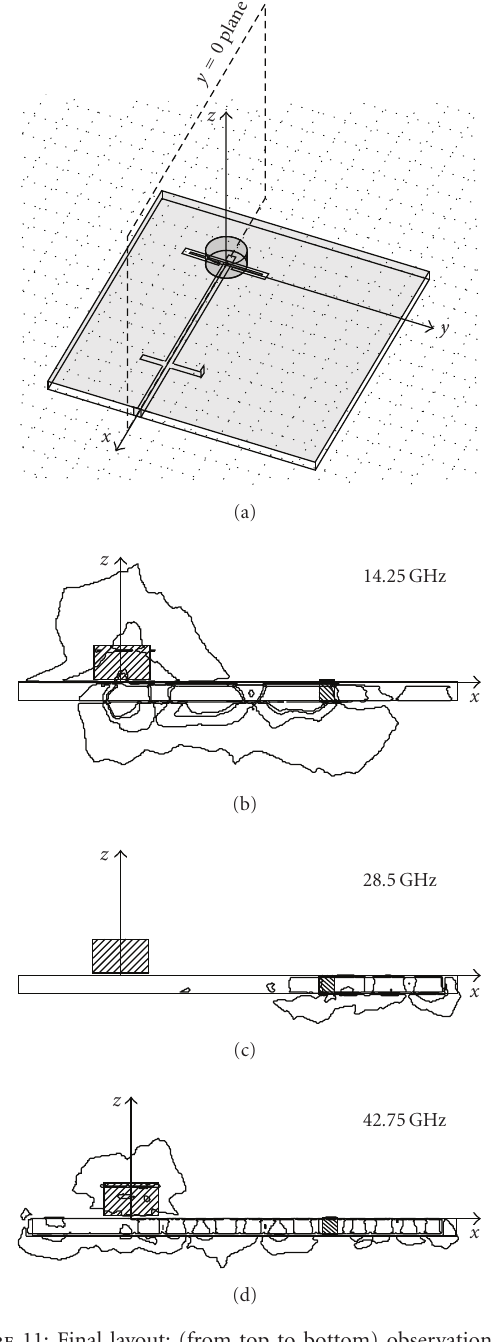
Figure 11: Final layout: (from top to bottom) observation plane geometry, electric field maps on y = 0 plane at 14.25 GHZ, 28.5GHz, and 42.75